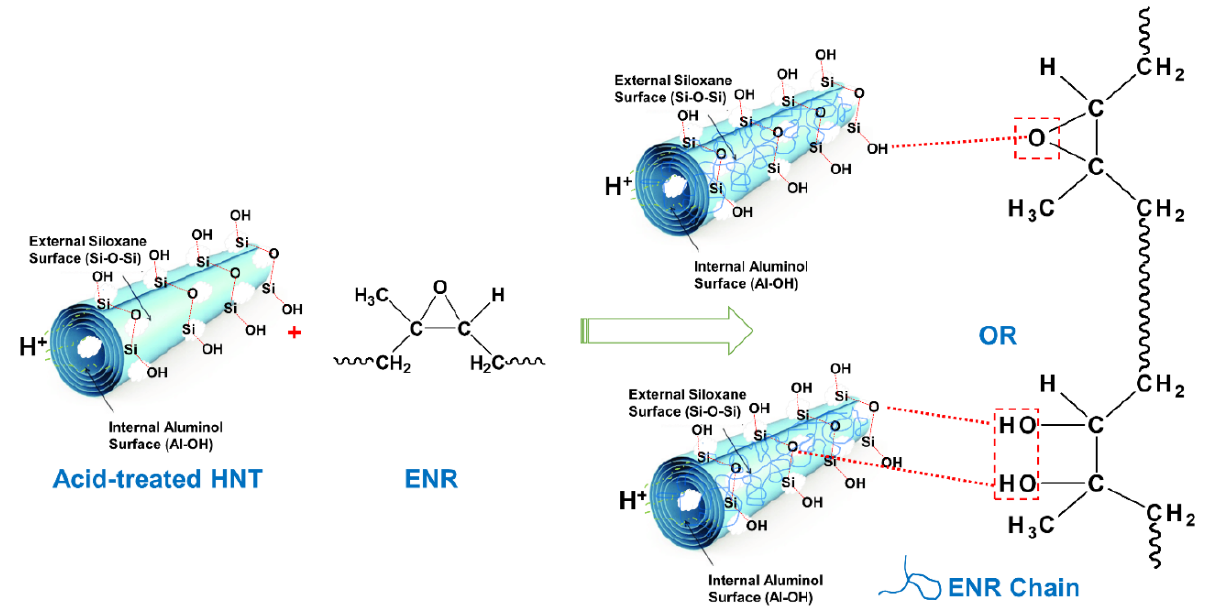
Figure 9. Possible interactions of ENR with acid-treated HNT